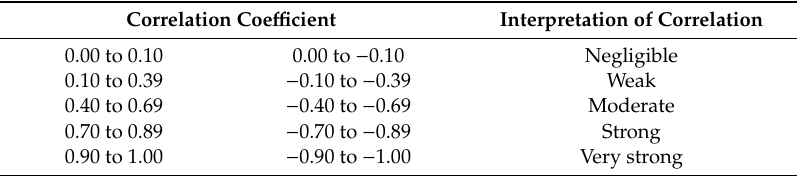
Table 1. Example of interpretations of the correlation coe ffi cient [32].